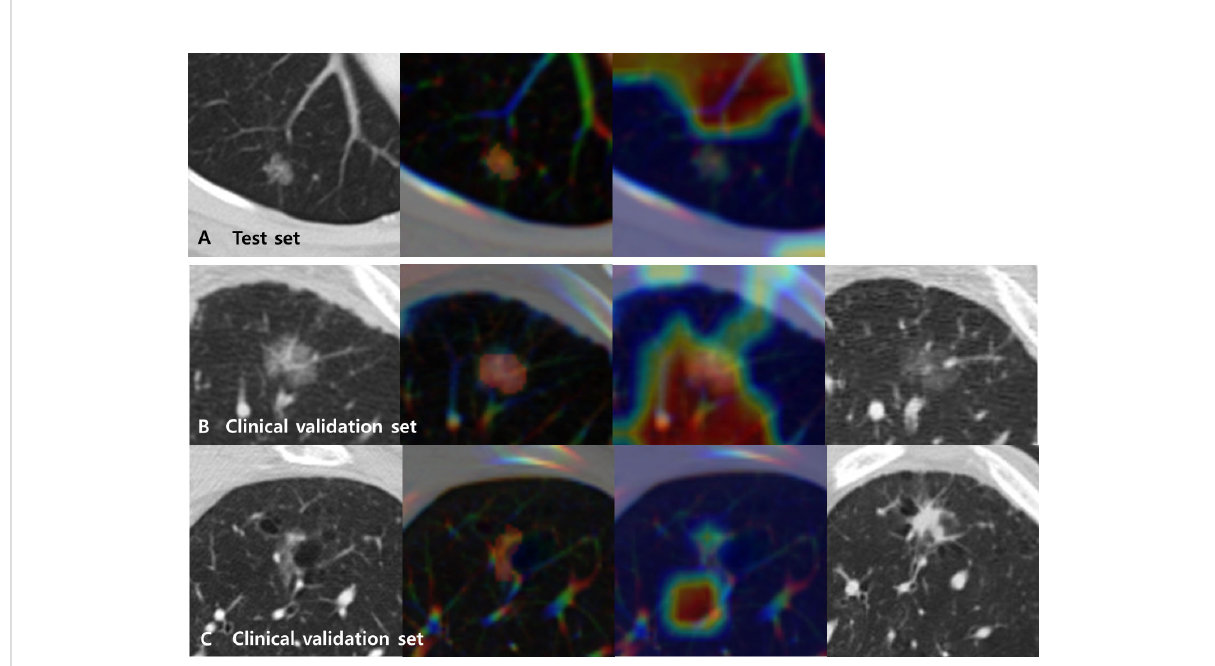
FIGURE 4 Representative CT images ( fi rst from the left) overlaid with regions of interest (ROIs) (second) and Grad-CAMs (third) for Multimodal Ef fi cientNet-b1 for Lung (MENL) interpretation. (A) A EGFR -mutant correct case (probability 0.62) in the test set. (B) A EGFR -mutant (response) correct case (probability 0.69) in the clinical validation set. Compared to the baseline CT image ( fi rst), the last follow-up CT image after TKI (fourth) demonstrates a decrease in density. (C) A EGFR -wild type (non-response) correct case (probability 0.51) in the clinical validation set. Compared to the baseline CT image ( fi rst), the last follow-up CT image after TKI (fourth) demonstrates an increase in size and density. In all cases, the tumor and its proximal bronchovascular bundle are activated by the